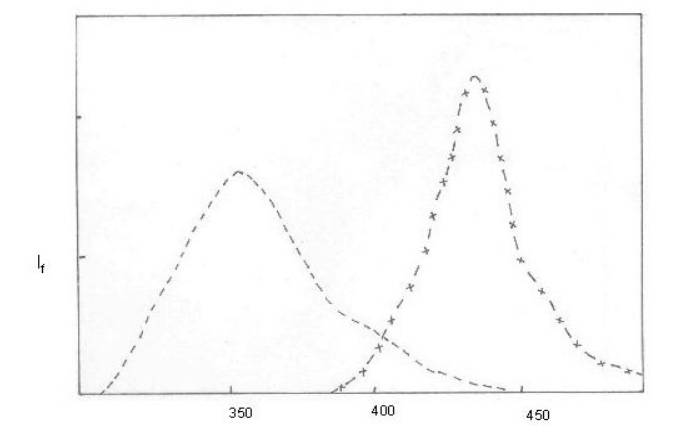
Figure 2 . Fluorescence spectra of different species of DAAQ.